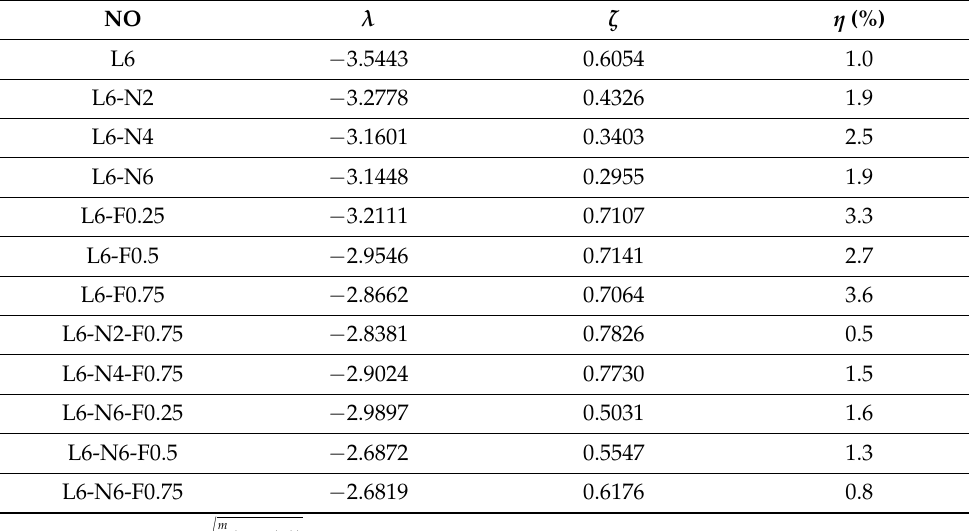
Table 4. Calculation results of λ and ζ.